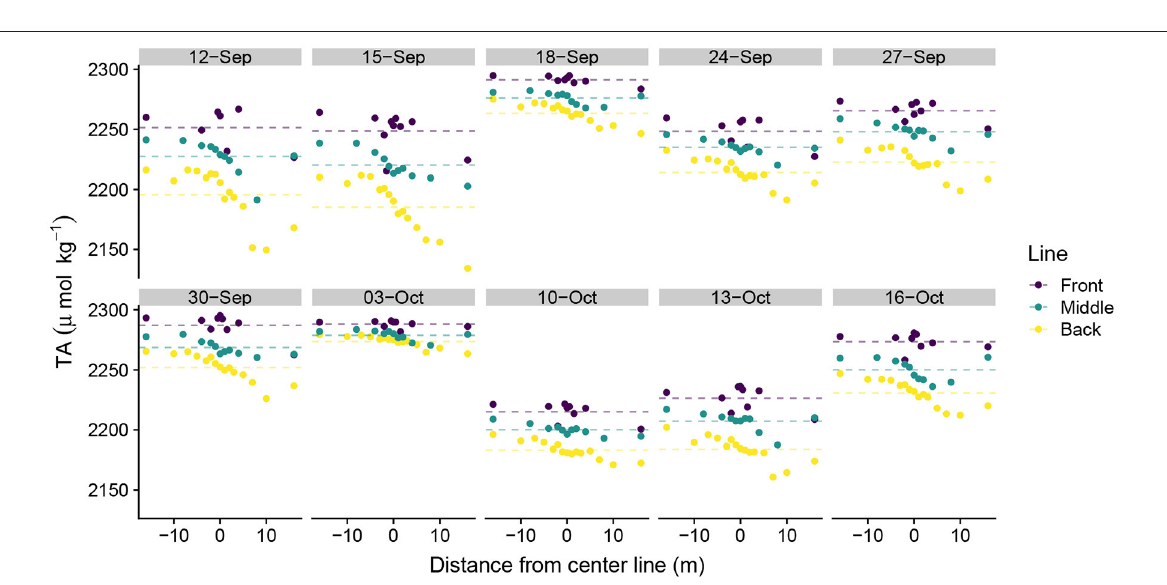
values on 03-October-2016 deviated from the patterns